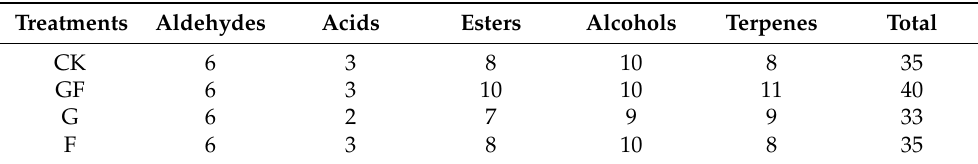
Table 3. The effect of the different treatments on the number of volatile aroma compounds in the ‘Hanxiangmi’ table grape at harvest. Treatments